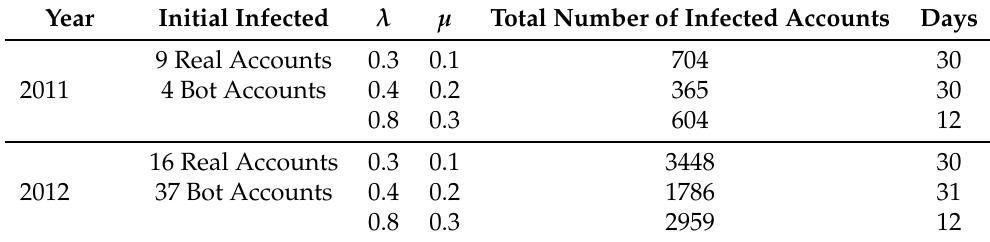
Table 5. The SIR Model Simulation Results.